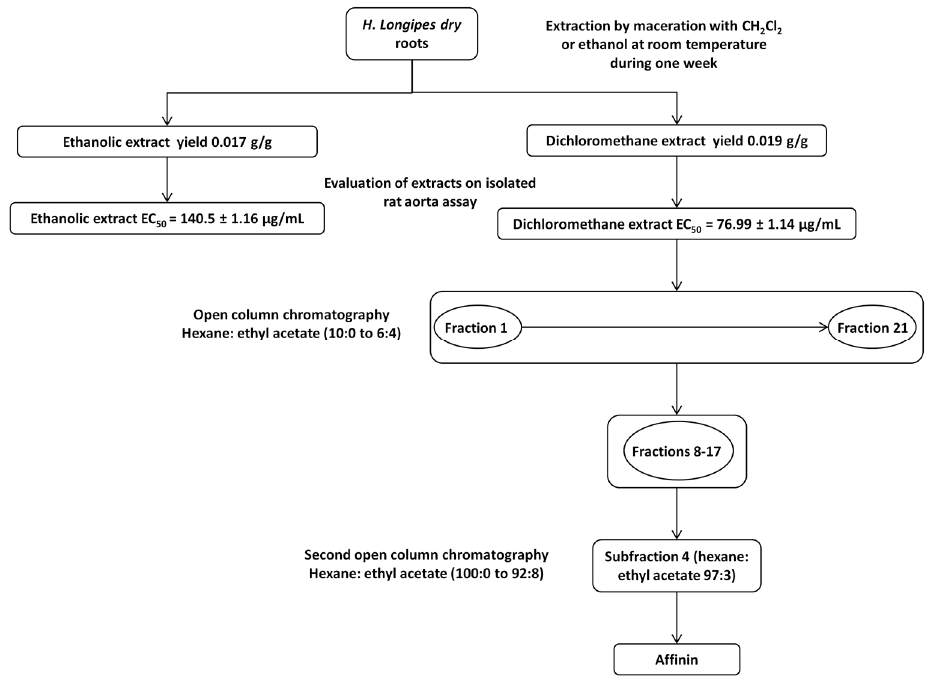
Figure 1. Diagram of the isolation of affinin from the dichloromethane extract of H. longipes roots. Affinin (Figure 2) was identified by comparison with an authentic sample and by comparing its spectroscopic data ( 1 H-NMR and 13 C-NMR) with those previously reported in the literature (Table 1). High performance liquid chromatography/photodiode array detector (HPLC-PDA) analysis of affinin revealed a purity >94%.